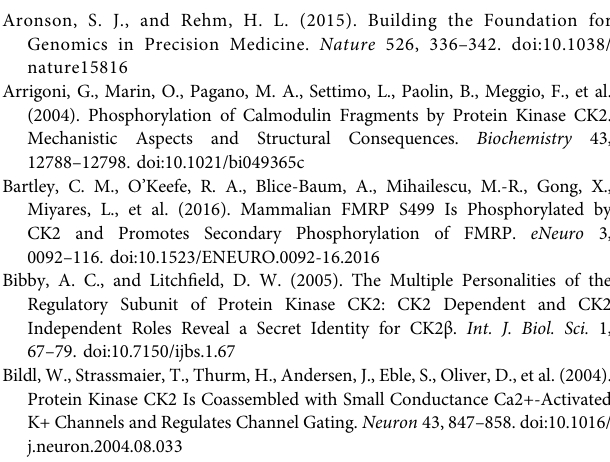
Supplementary Table S1 | Detailed table of OCNDS patients and their symptom pro fi les. All patients whose symptoms were published thus far are ordered by the position of the gene variation, position within the gene structure as well as the effect on amino acid sequence, as far as it could be predicted. More detailed information about the different symptoms is given in this table. Abbreviations: ATP: Adenosine triphosphate; GTP: Guanosine triphosphate; yo: years old; mo: months old; ID: Intellectual Disability; LD: Learning disability; ADHD: Attention de fi cit hyperactivity disorder; GTCS: generalized tonic-clonic seizure; GERD: Gastroesophageal re fl ux disease; G-tube: Gastrostomy tube; EEG: Electroencephalography; MRI: Magnetic resonance imaging. Supplementary Table S2 | Detailed table of POBINDS patients and their symptom pro fi les. All patients whose symptoms were published thus far are ordered by the position of the gene variation, position within the gene structure as well as the effect on amino acid sequence, as far as it could be predicted. More detailed information about the different symptoms is given in this table. Abbreviations: D Box: Destruction box; yo: years old; mo: months old;